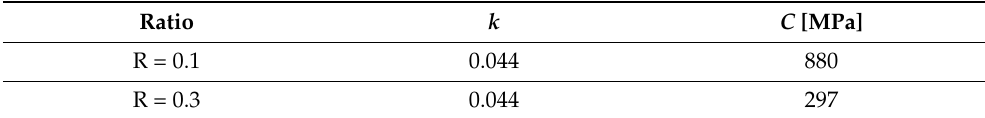
Table 9. Number of cycles and their relative stresses for R = 0.1 and R = 0.3. Ratio